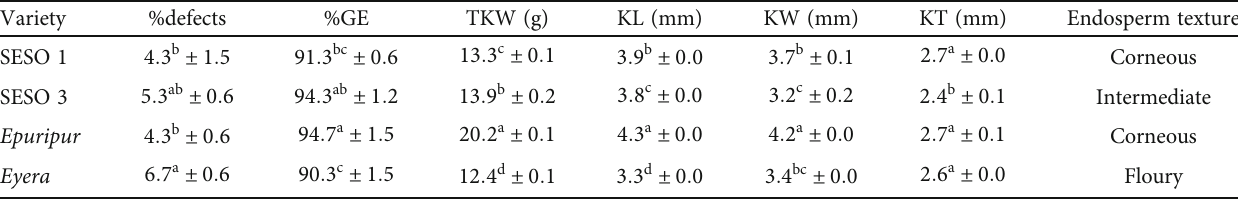
Table 1: Physical properties of grain sorghum varieties.